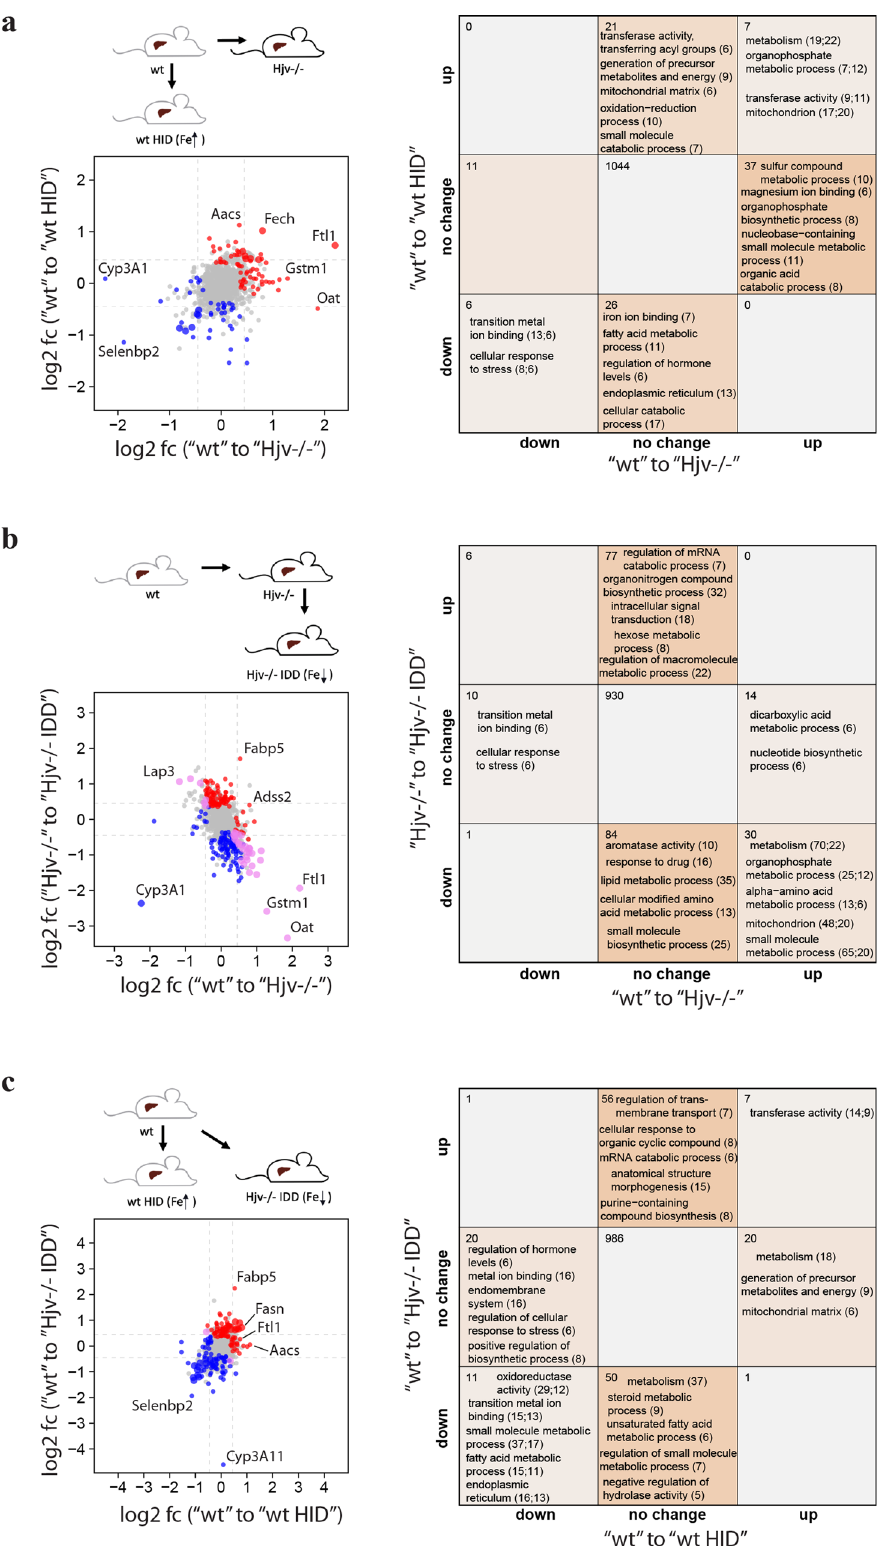
Fig. 7 Comparative analysis of liver proteomes in wild type and Hjv − / − mice following dietary iron manipulations. a Liver proteomic changes in response to high iron diet (HID) versus Hjv de fi ciency. b Liver proteomic changes in response to Hjv de fi ciency and relative dietary iron depletion. c Liver proteomic changes between wild type mice on standard diet versus wild type mice on HID and Hjv − / − mice on IDD. (Left) Log2 fold-changes (log2 fc) of differentially expressed proteins (Tukey p < 0.05, abs. log2 fold change >0.35). Red = upregulated, blue = downregulated, large point = signi fi cant in both. (Right) Number of signi fi cantly changed proteins and enriched annotations (Fisher ’ s exact test p < 0.05) of respective protein sets.